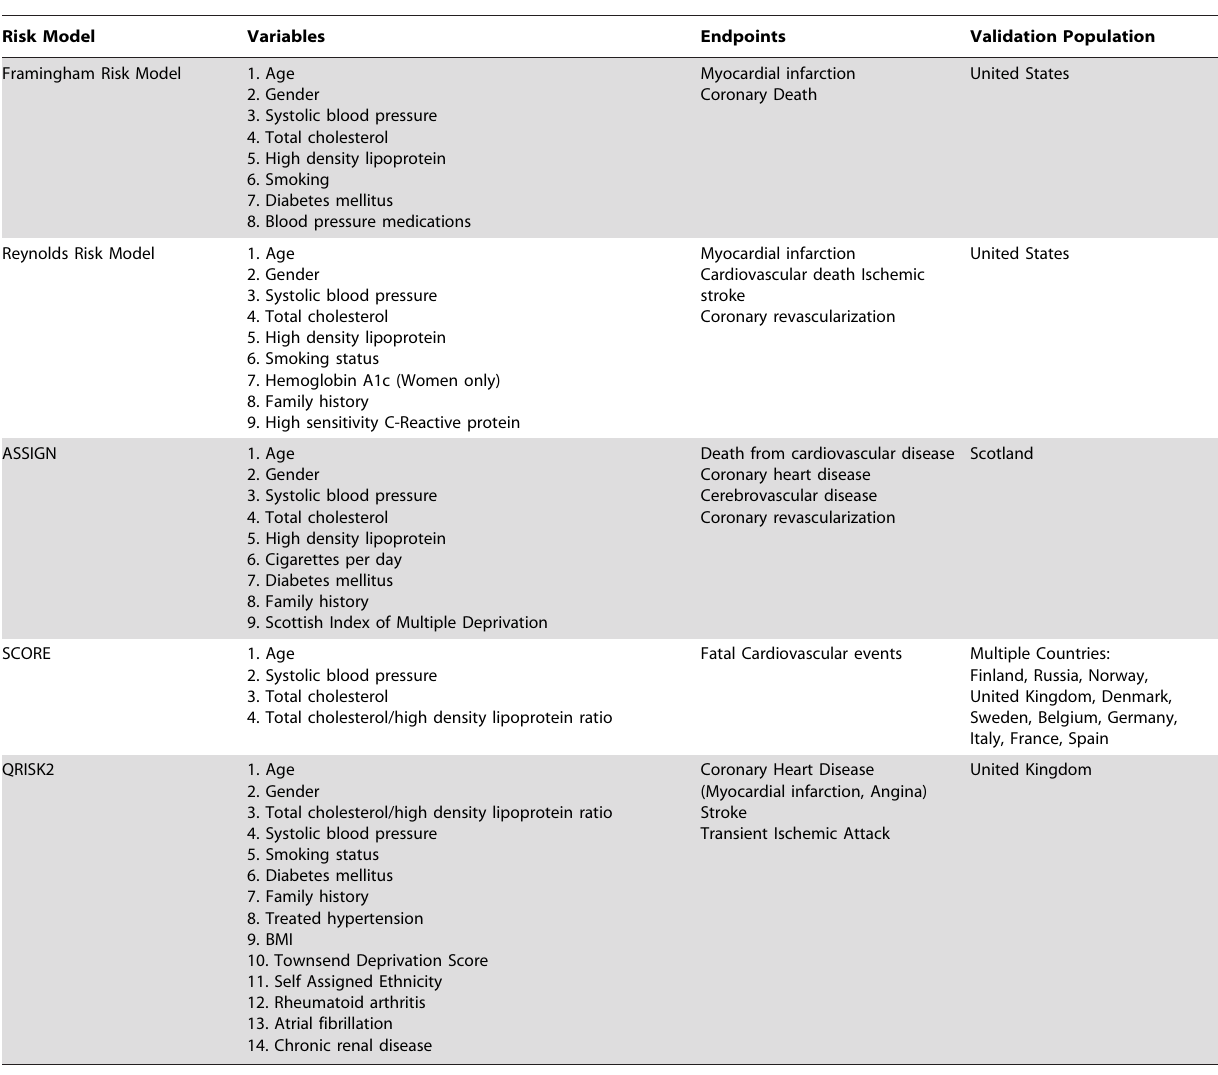
Table 1. Overview of Risk